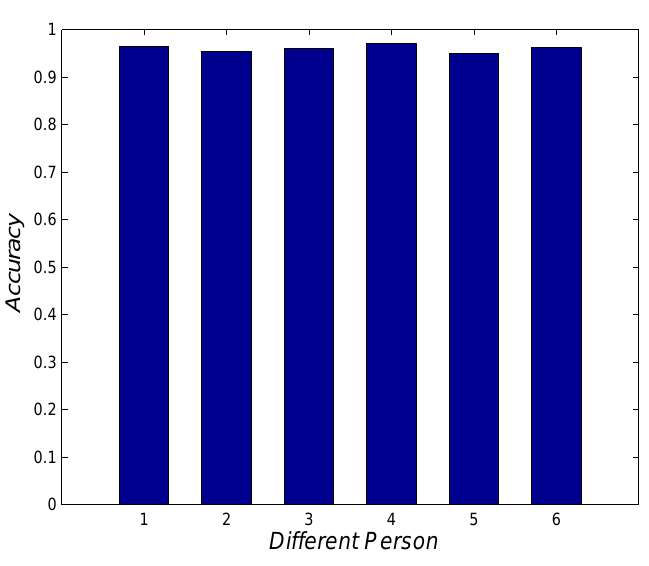
Figure 13. Localization result in underground